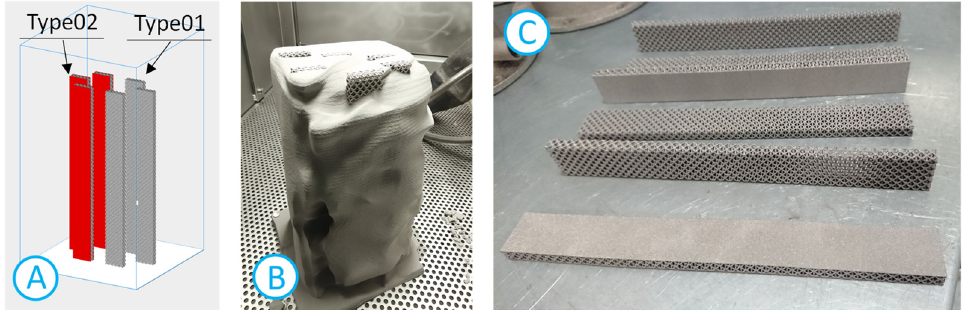
Figure 6. ( A ) Job layout; ( B ) specimen at the end of the manufacturing process; ( C ) post-processed specimens.